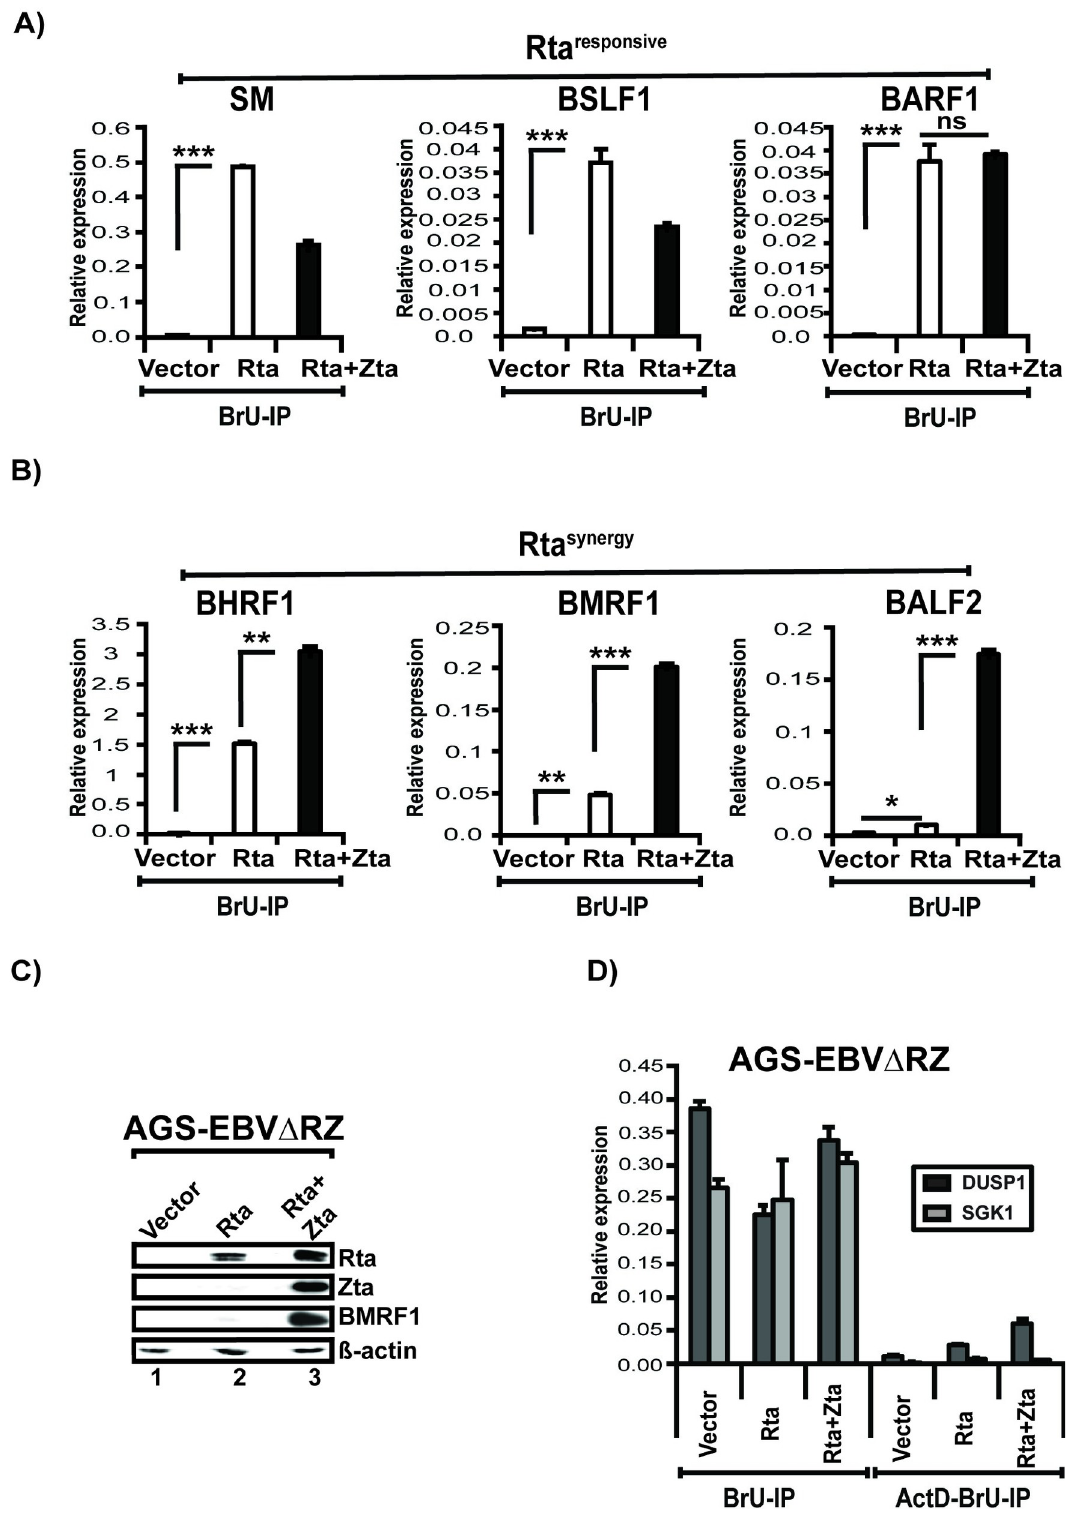
Fig 10. Zta increases nascent transcription of the early lytic Rta synergy but not Rta responsive gene transcripts. (A) BrU-labelling assay for nascent transcription of the SM, BSLF1, and BARF1 Rta responsive transcripts. Forty-eight hours following transfection with vector, Rta, or Rta+Zta, AGS-EBV Δ RZ cells were pulse-labelled with BrU for 1 hour, subjected to anti-BrU immunoprecipitation,